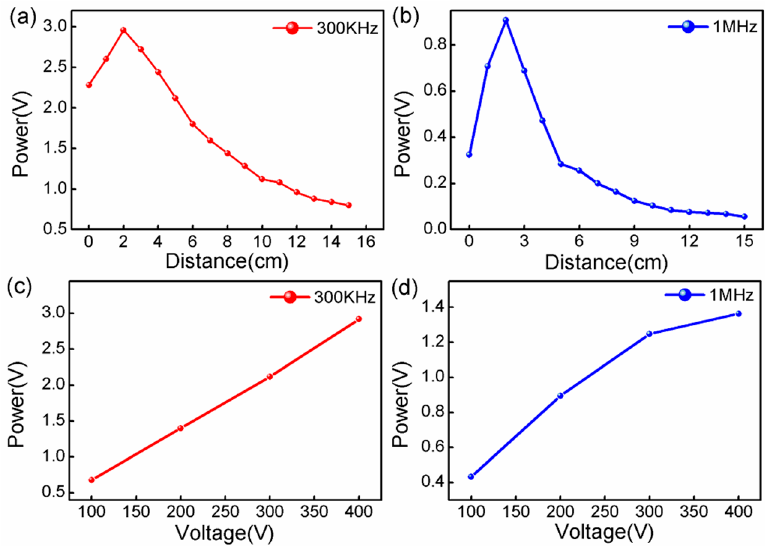
Figure 5. Experiment measurements: ( a , b ) UW power of 300 kHz and 1 MHz versus increasing distances at the fixed emission voltage; ( c , d ) UW power of 300 kHz and 1 MHz versus increasing voltage at a fixed distance.